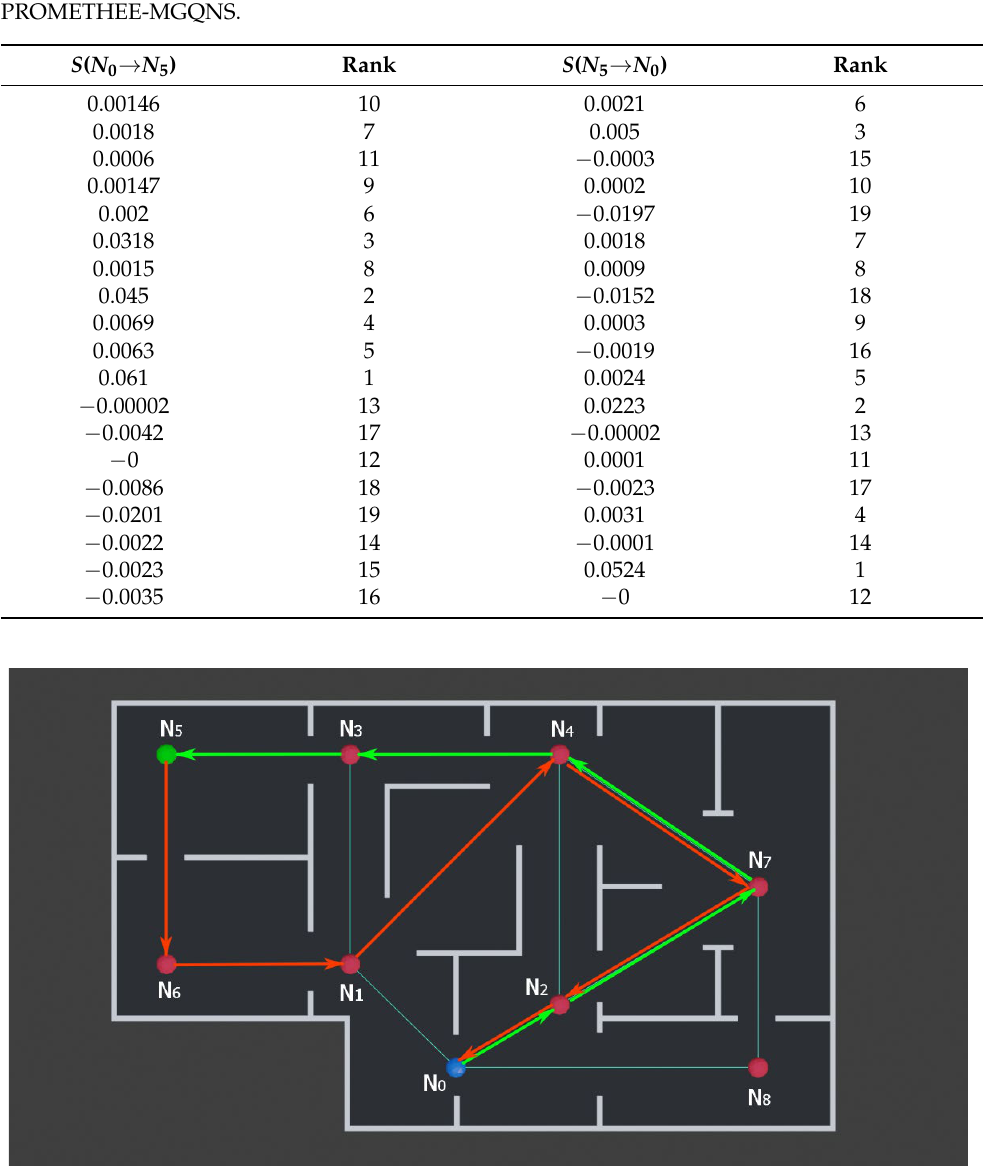
and routes, marked by green and red arrows, respec- Figure 3. The computed Figure 3. The computed N 0 → N 5 and N 5 → N 0 routes, marked by green and red tively. arrows, 𝑁𝑁 0 → 𝑁𝑁 5 𝑁𝑁 5 → 𝑁𝑁 0